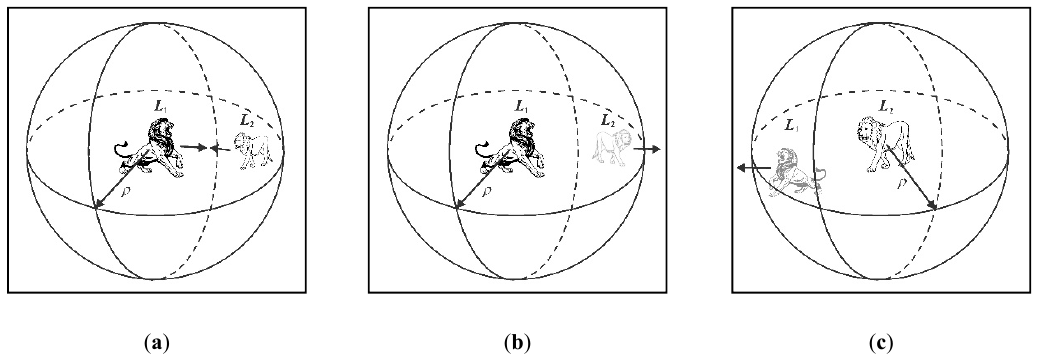
Figure 4. Competition phase ( a ) when L 2 enters to the radius of L 1 , ( b ) L 1 remains unbeaten ( c ) L 2 remains unbeaten.